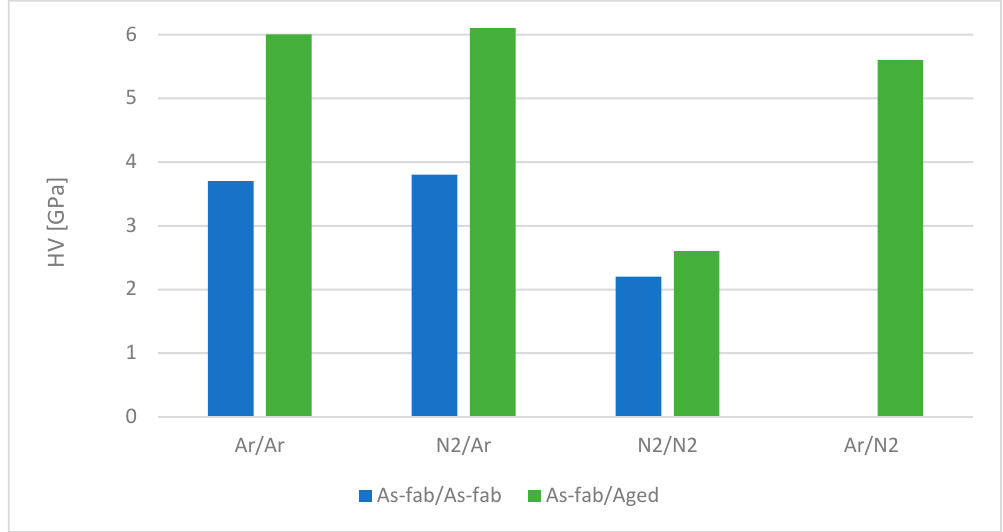
Figure 18. Experimental results from [137]: Vickers microhardness (HV) on as-manufactured samples (blue piles) and after aging at 482 °C for 1 h and air-cooled standard H900 heat treatment (green piles). Ar/Ar and N 2 /Ar refer respectively to Ar- and N 2 -atomized powders, both L-PBF processed in Ar atmosphere; similarly, Ar/N 2 and N 2 /N 2 refer to Ar- and N 2 -atomized powders, L-PBF fabricated in